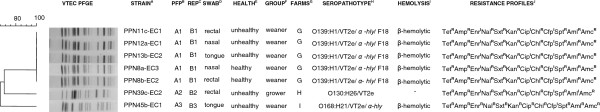
Dendrogram generated from PFGE profiles of the VTEC strains using UPGMA based on Dice coefficients of similarity.AStrain code; Bpulsotype; CREP profiles; Dswab samples; Ehealth condition of pig; Fage group; Gswine farm; Hserotype/virulence factor/hemolysin gene/adhesin; Iphenotypic result for haemolytic activity on washed blood agar; Jantimicrobial resistance profiles.